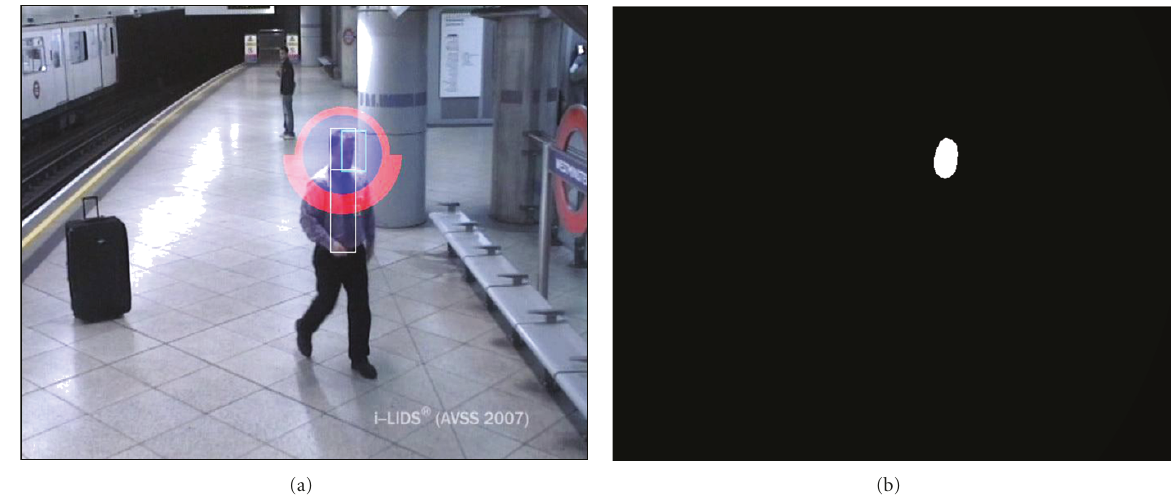
Figure 4: (a) input video frame with localized search region indicated by red circle. (b) the Cr detection result within the search region.